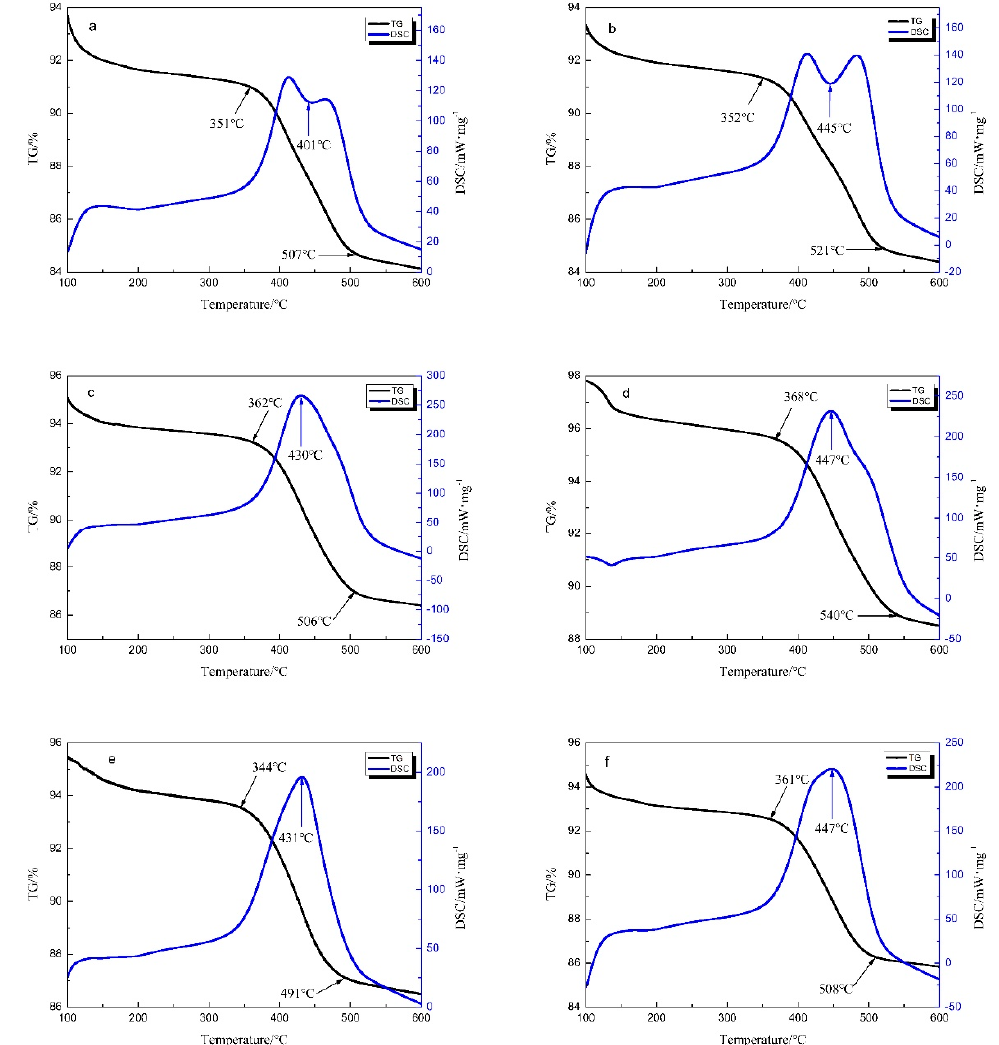
Figure 4. TG-DSC analysis of samples ( a )K / ZC + soot, ( b ) Zr / ZC + soot, ( c ) Co / ZC + soot, ( d ) ZC + soot, ( e )Co / CZ + soot, ( f ) CZ + soot.